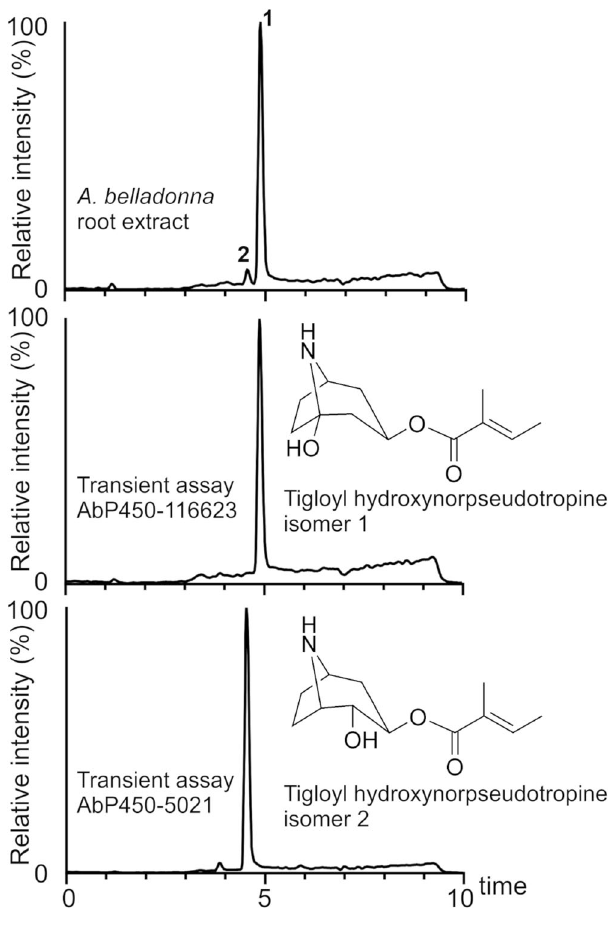
Fig. 4 Comparative analysis of tigloyl hydroxynorpseudotropine isomers produced in A. belladonna root and N. benthamiana transient assays. N. benthamiana leaves producing AbP450-5021 and AbP450-116623 were assayed with tigloyl norpseudotropine for ring-hydroxylase activity. Metabolite extracts were analyzed by UHPLC/MS using a 10-min gradient elution method. Each chromatogram represents an extracted ion chromatogram for m/z 226.14. NMR con fi rmed structures are shown for tigloyl hydroxynorpseudotropine isomers 1 and 2 that were puri fi ed from up-scaled transient assays (this study, Supplementary Data 6). 1, A. belladonna tigloyl hydroxynorpseudotropine isomer 1 ( 25 ); 2, A.